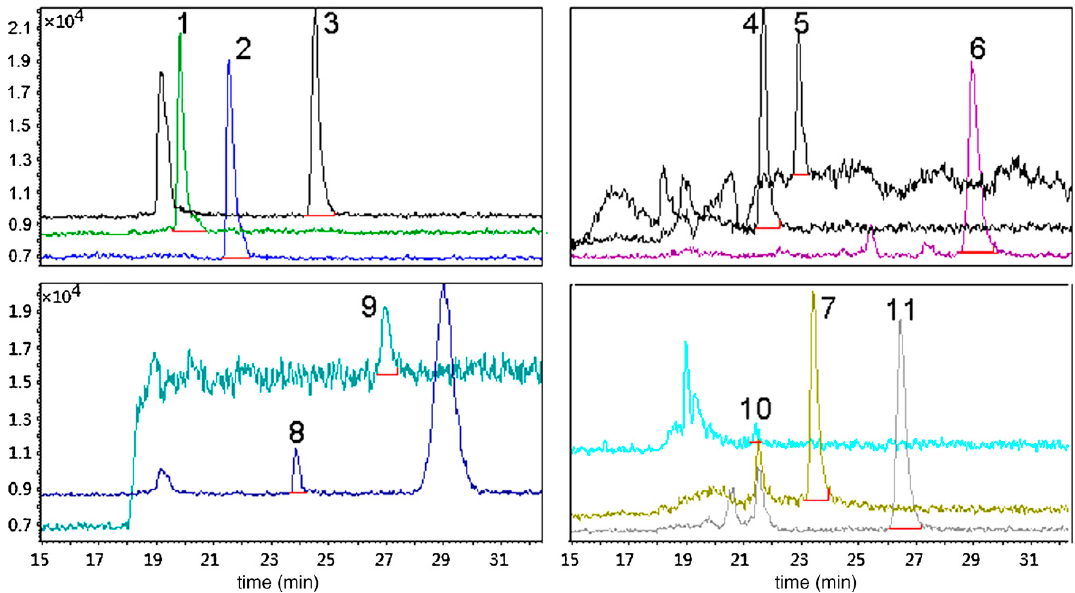
Figure 5. LC / MS SIM chromatograms from the analysis of plasma sample spiked with 10 antidepressant Figure 5. LC/MS SIM chromatograms from the analysis of plasma sample spiked with 10 drugs after in-tube SPME (Peaks: 1, trazodone; 2, citalopram; 3, amitriptyline; 4, doxepin; 5, paroxetine; antidepressant drugs after in-tube SPME (Peaks: 1, trazodone ; 2, citalopram; 3, amitriptyline; 4, 6, clomipramine; 7, imipramine (internal standard); 8, fluvoxamine; 9, sertraline; 10, clozapine; 11, doxepin; 5, paroxetine; 6, clomipramine; 7, imipramine (internal standard); 8, fluvoxamine; 9, fluoxetine. Adopted from [83] with sertraline; 10, clozapine; 11, fluoxetine. Adopted from [83] with permissions. A polypyrrole-coated capillary column has been utilized for the extraction of a racemic mixture of fluoxetine from human plasma samples [125]. The separation of the drug enantiomers has been carried out on a tris -(3,5-dimethylphenyl carbamate) cellulose column (Chiralcel OD-R) using a mixture of potassium hexafluorophosphate 7.5 mM and sodium phosphate 0.25 M solution (pH 3.0)/CH 3 CN (75/25, v / v ) as mobile phase. The performance of the synthesized polypyrrole-